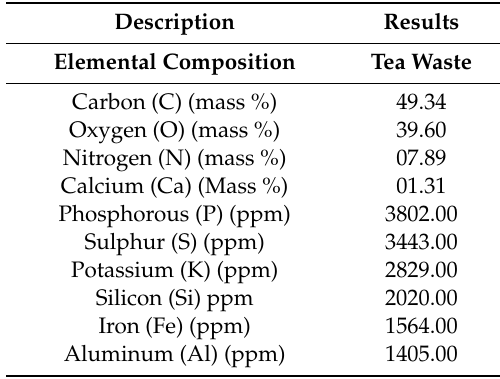
Table 3. Elemental composition of used black tea waste particles.